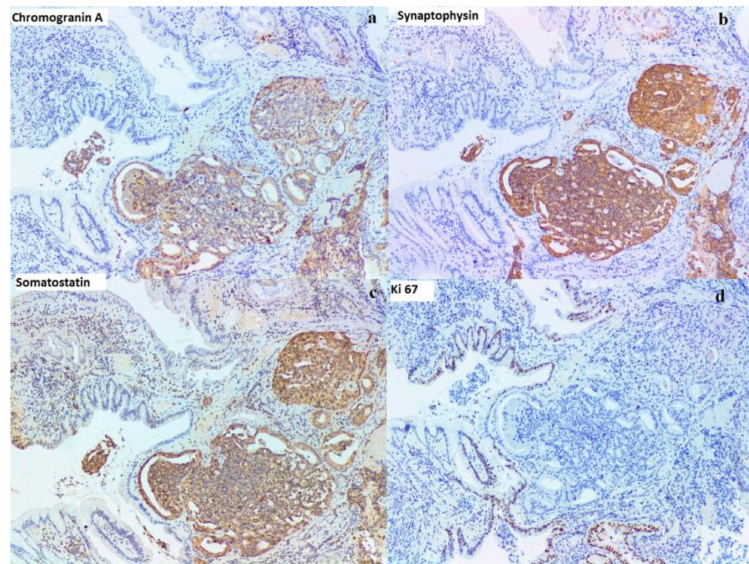
Figure 9. Imnuohistochemistry findings 40X. ( a ) Chromogranin A (Cell Marque, monoclonal, dilution 1:100): positive reaction of the tumoral cells, cytoplasmic, with internal positive control. ( b ) Synaptophysin (Immunopath, monoclonal, dilution 1:500): positive reaction of the tumoral cells, cytoplasmic, with internal positive control. ( c ) Somatostatin (Abcam, monoclonal, dilution 1:200): positive reaction of the tumoral cells, cytoplasmic, with internal positive control. ( d ) Ki67 (Leika, monoclonal, dilution 1:100): 1% in tumoral cells, with internal positive control in cryptic epithelial